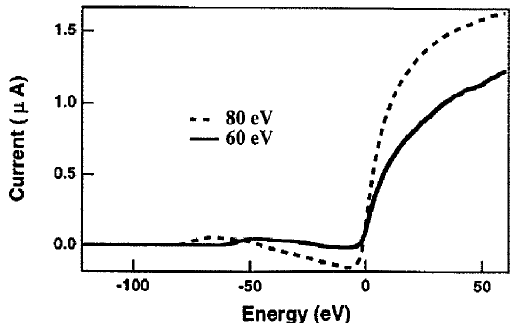
FIG. 6. Signal produced from a BPM irradiated by 60-eVand 80-eV electrons as a function of bias voltage applied to the BPM [13]. Similar signals were observed with the BPMs installed in the ring during the electron-cloud experiments.